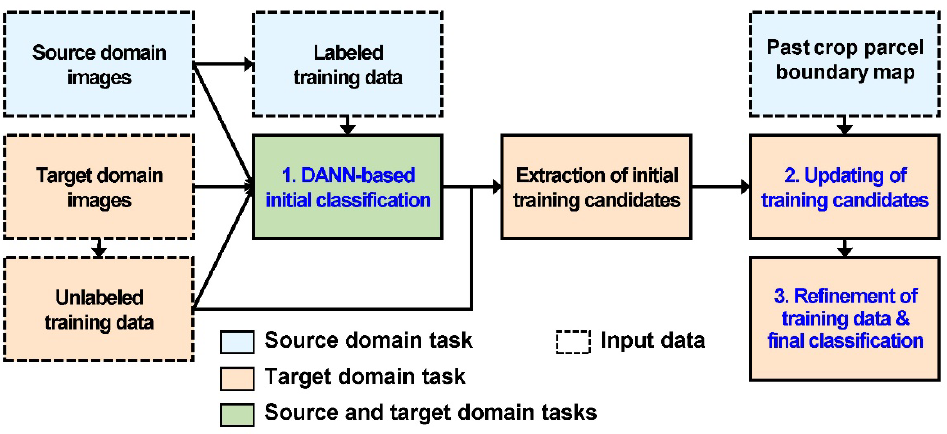
Figure 1. A flowchart of the classification procedures of STDAN.